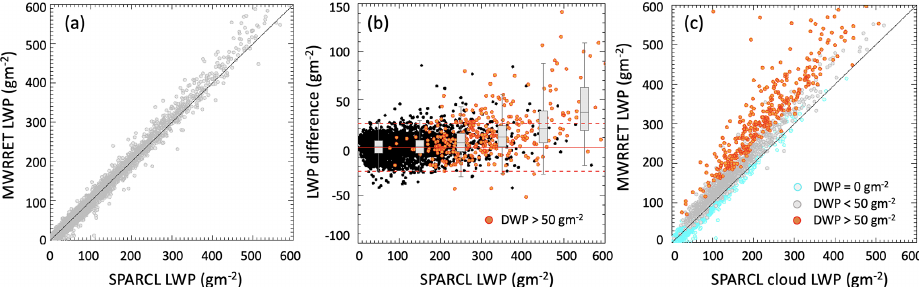
Figure A1. (a) Scatterplot between total LWP in this work (SPARCL) and physical retrieval (MWRRET) LWP. (b) Difference between the two retrievals (MWRRET minus SPARCL) for all samples (black) and samples with below-cloud drizzle water path greater than 50gm − 2 (orange). The dashed horizontal orange lines indicate ± 25gm − 2 . (c) Scatterplot between SPARCL cloud water path and MWRRET LWP. Colors represent cases with no drizzle (cyan), drizzle water path below the cloud base less than 50gm − 2 (grey), and drizzle water path below the cloud base greater than 50gm − 2 .